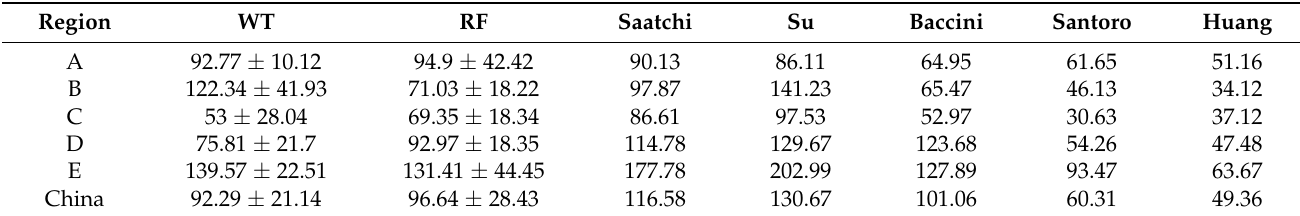
Table 2. Mean AGB ± one standard error in Mg/ha computed for the hybrid AGB maps (i.e., derived by RF and WT) and each of the Saatchi, Su, Baccini, Santoro, and Huang maps.